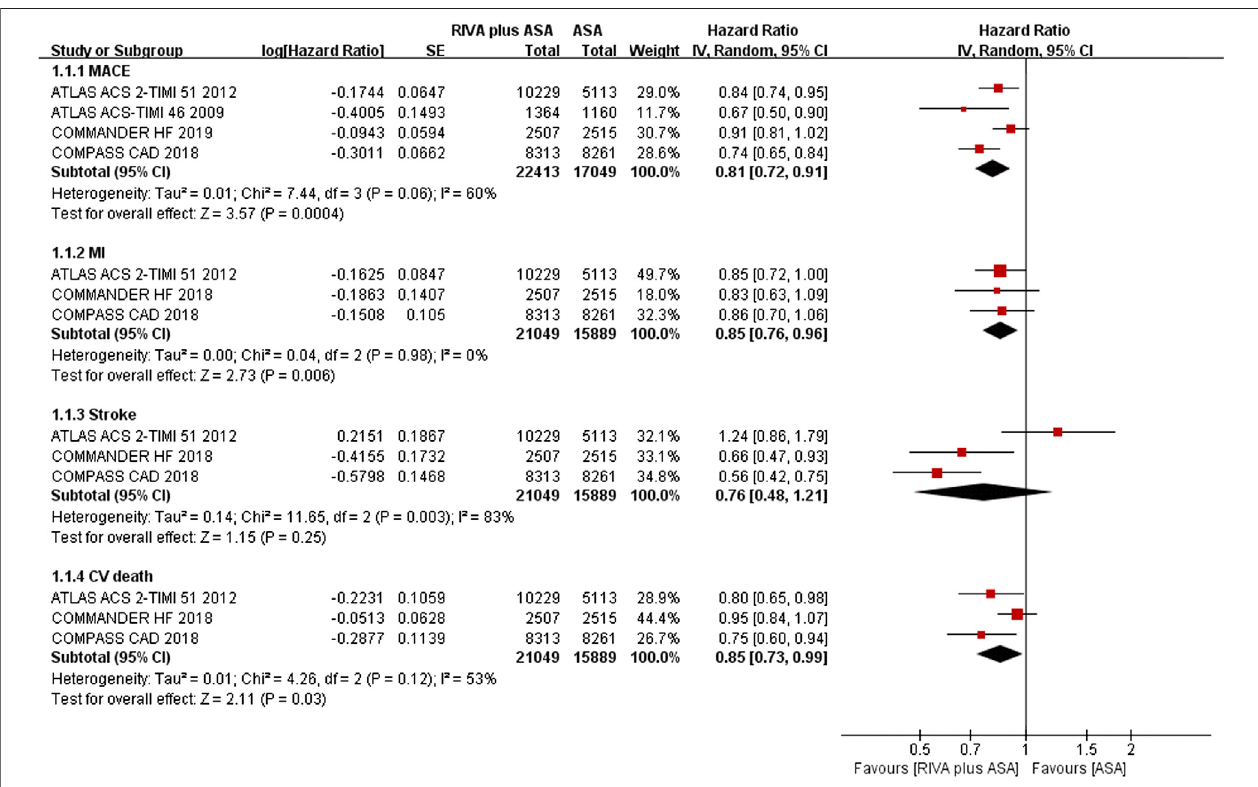
FIGURE 2 | Forest plot of the risk of MACEs in coronary artery disease patients treated with rivaroxaban plus aspirin and aspirin. MACE, major adverse cardiovascularevent;MI,myocardialinfarction;CV,Cardiovascular;RIVA,rivaroxaban;ASA,aspirin;IV,inversevariance;COMPASSCAD,coronaryarterydiseaseinthe Cardiovascular Outcomes for People Using Anticoagulation Strategies trial; COMMANDER HF, A Study to Assess the Effectiveness and Safety of Rivaroxaban in Reducing the Risk of Death, Myocardial Infarction, or Stroke in Participants with Heart Failure and Coronary Artery Disease Following an Episode of DecompensatedHeartFailure;ATLASACS2-TIMI51,Anti-XaTherapytoLowerCardiovascularEventsinAdditiontoStandardTherapyinSubjectswithAcuteCoronary Syndrome-ThrombolysisinMyocardialInfarction5;ATLASACS-TIMI46,RivaroxabaninCombinationWithAspirinAloneorWithAspirinandaThienopyridineinPatients With Acute Coronary Syndromes.